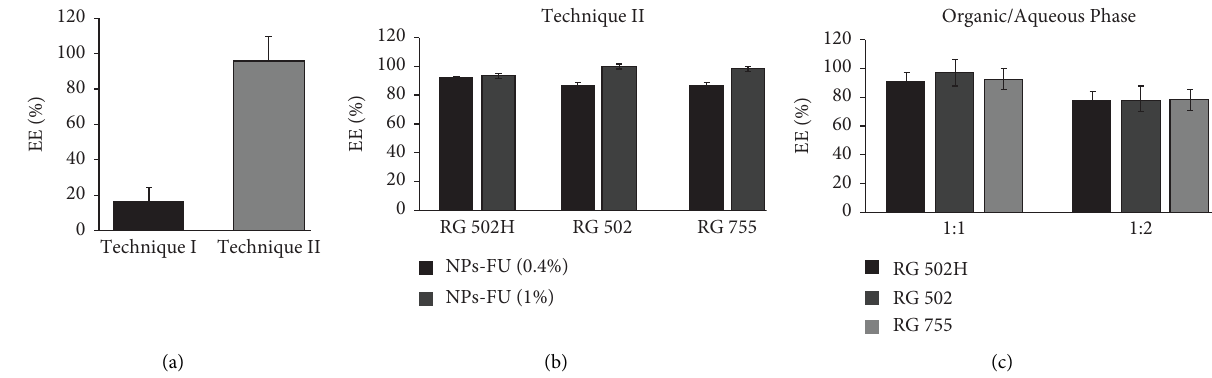
Figure 2: Shows the percentage of FU that is incorporated into PLGA-NPs. Te following factors can have an impact: (a) the technique used to prepare the organic phase; (b) the copolymers melting point and combination (RRG502H; GA/LA 50: 50; RRG 502; GA/LA 50:50; RRG 755; GA/LA 75:25); (c) the ratio of the organic to aqueous phase. Te nanoprecipitation procedure was used to prepare